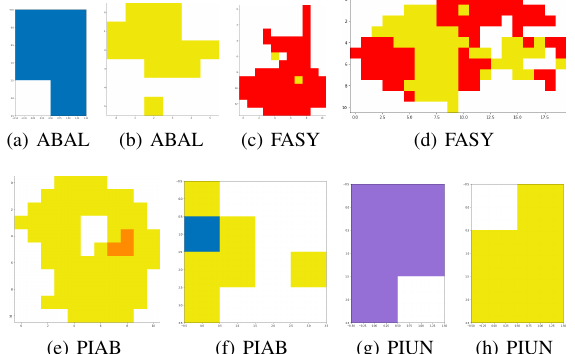
Figure 4: Results of pixel classification for tree-level assess- ment of 8 tree crowns: (a) ABAL tree correctly detected, (b) ABAL tree detected as PIAB, (c) FASY tree correctly detected, (d) FASY tree correctly detected with an important amount of PIAB pixels, (e) and (f) PIAB trees correctly detected with few pixels from other species, (g) PIUN tree correctly detected and (h) PIUN tree dectected as PIAB. Legend: Abies alba (ABAL), Fagus sylvatica (FASY), Picea abies (PIAB), Pinus unci- nata (PIUN) and other